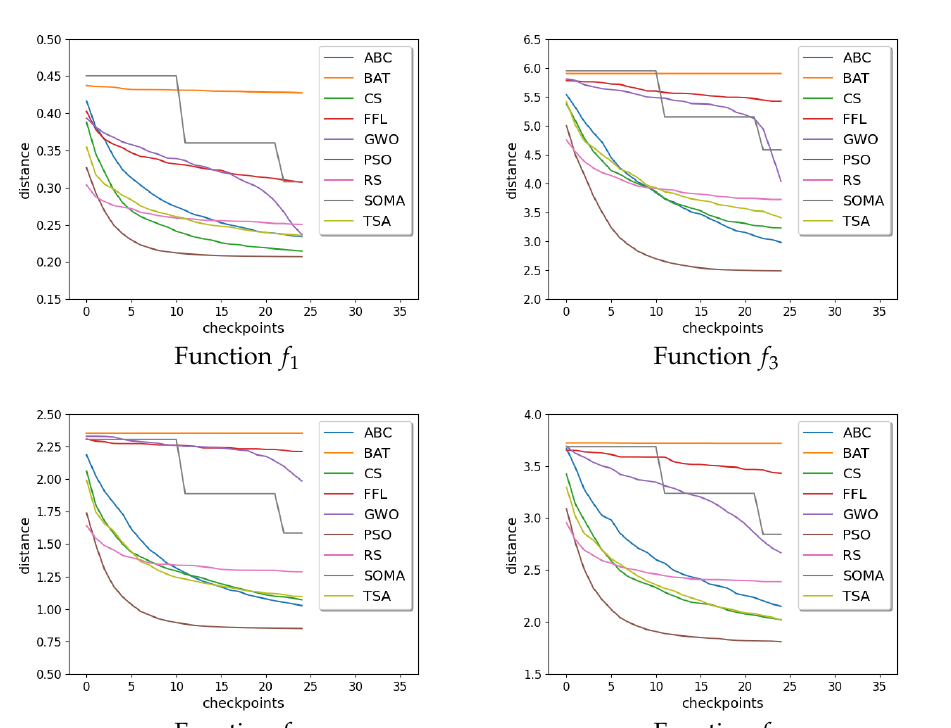
Figure 3. Graphs of distance convergence means for maxFES = 2500.